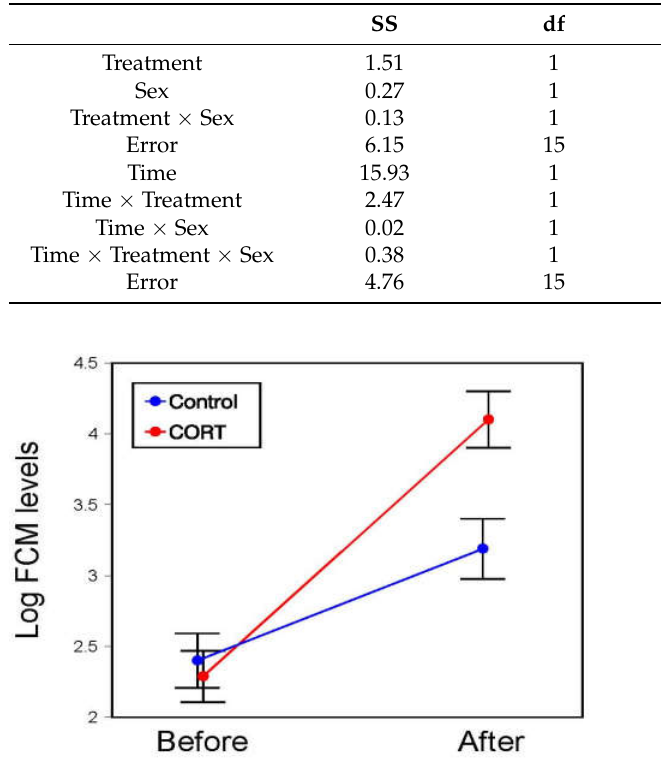
Figure 2. Mean ( ± SE) levels of fecal corticosterone metabolites (log 10 -transformed FCM; ng/g dry excrement) before and after a corticosterone supplementation experiment of control (blue) and experimental (CORT; red) individual T. wiegmanni amphisbaenians. Table 1. Results of a GLM testing the effects of a corticosterone supplementation experiment on the fecal corticosterone metabolites (FCM) levels of the amphisbaenian T. wiegmanni .